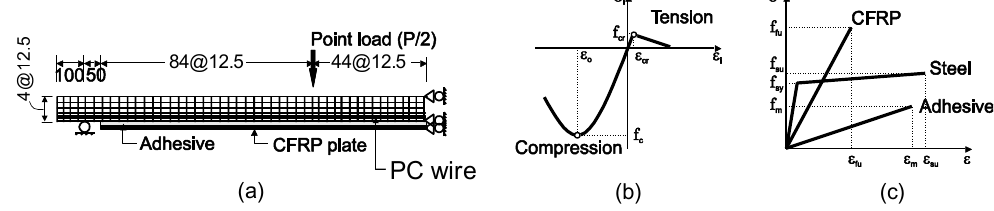
Figure 7. ( a ) FE mesh and geometry, ( b ) concrete constitutive model and ( c ) reinforcement (CFRP/steel/adhesive).